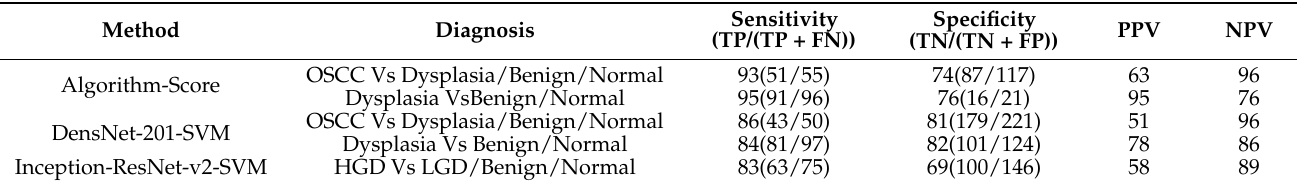
Table 1. Sensitivity and specificity of simple algorithm and ANN. OSCC: Oral Squamous Cell Carcinoma, HGD: High Grade Dysplasia, LGD: Low Grade Dysplasia, TP: True positive, TN: True negative, FN: False negative, FP: False positive. Method Algorithm ‐ Score